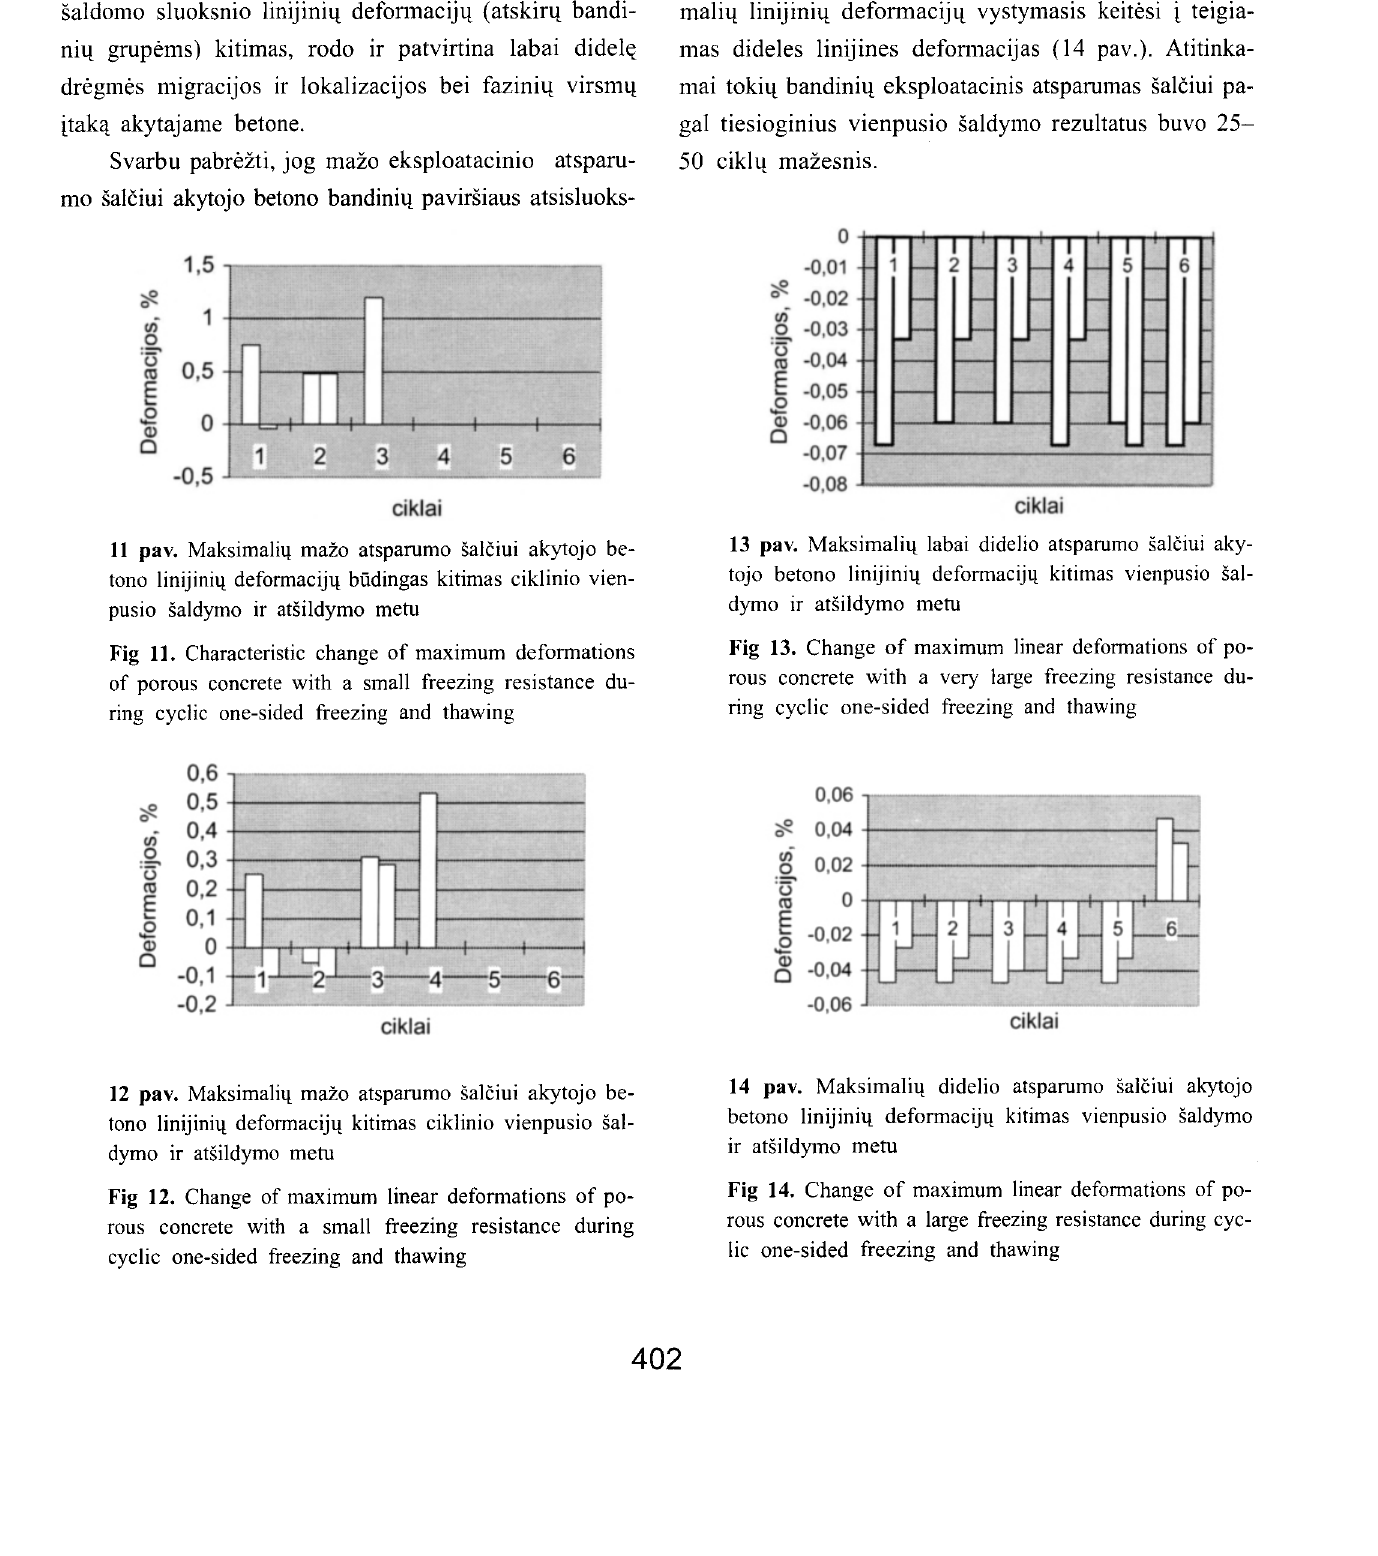
Fig 14. Change of maximum linear deformations of po rous concrete with a large freezing resistance during cyc lic one-sided freezing and thawing